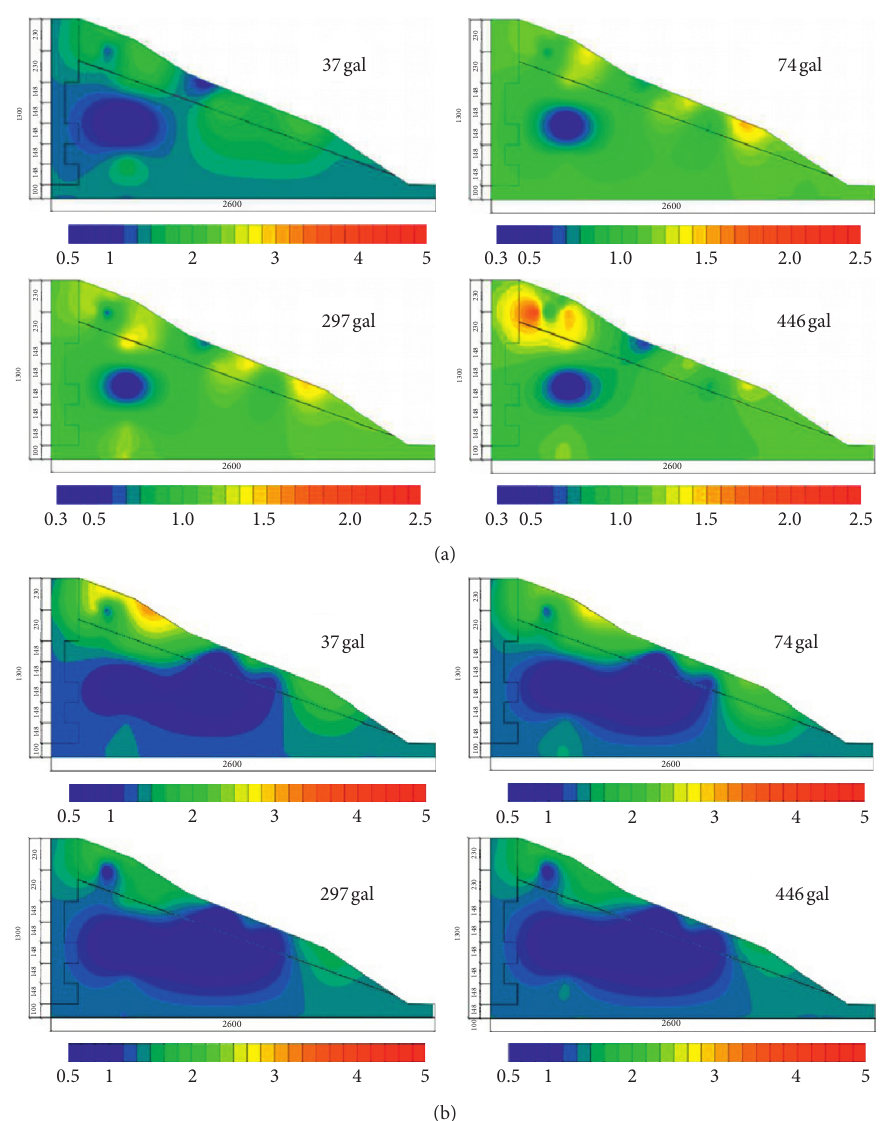
Figure 13: Acceleration amplification coefficient distribution of the Huaping slope model: (a) input in z direction; (b) input in x